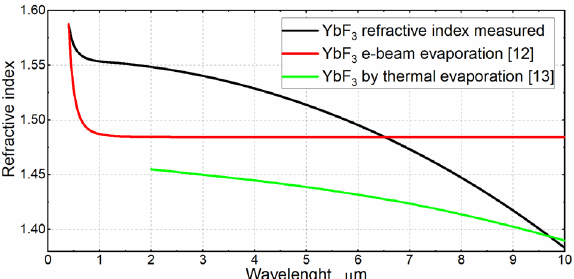
Figure 2. The black curve is the obtained refractive index dispersion of an YbF 3 monolayer by IBS method; the red curve is dispersion of an YbF3 film by e-beam evaporation taken from [12]; the green curve is dispersion of an YbF3 film by thermal evaporation taken from [13]. The dispersion characteristic agrees with the data obtained by the IBS method in [4].